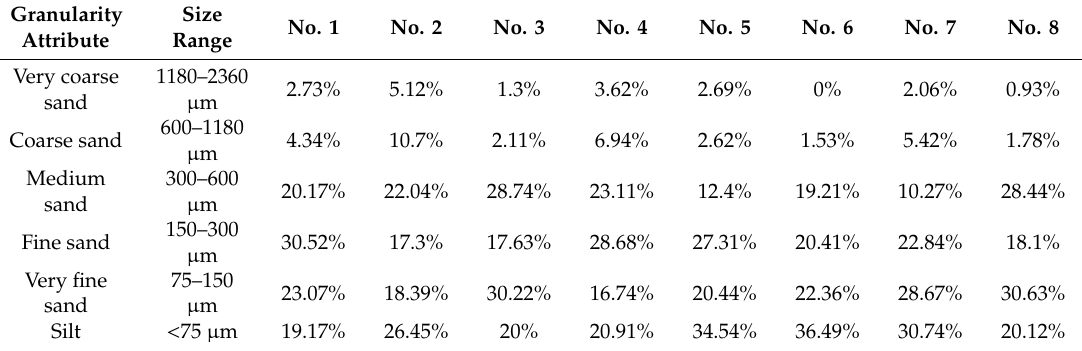
Table 10. Particle size distribution of clogging materials at di ff erent collection locations in